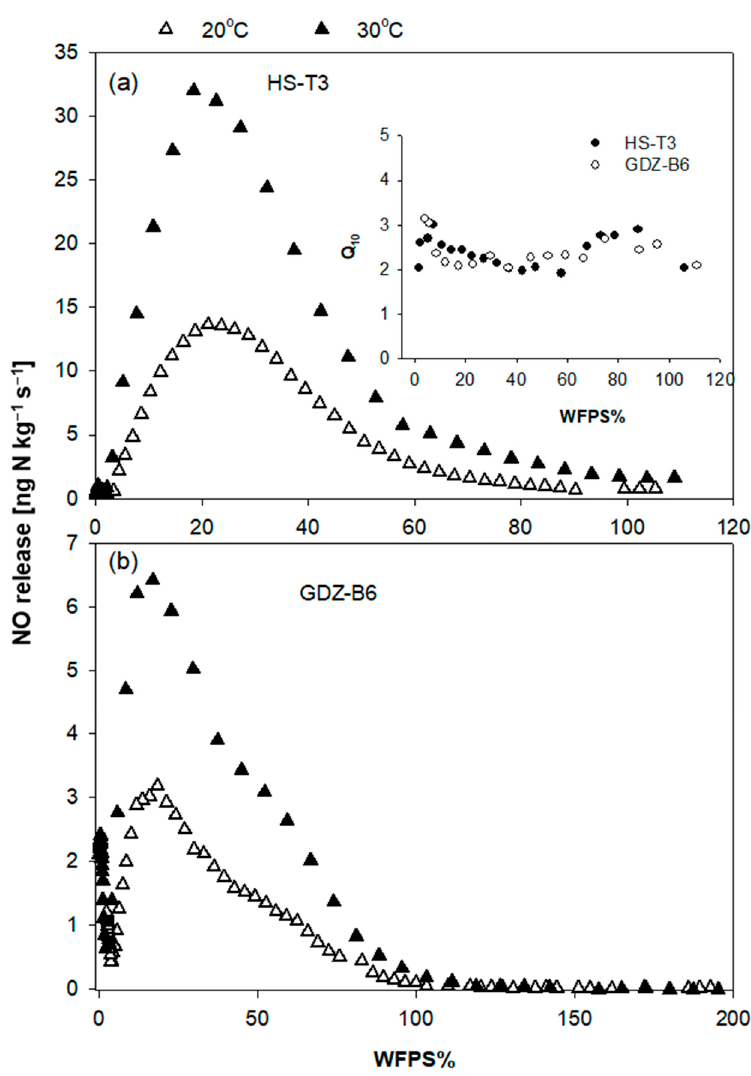
Figure 3. Effect of temperature on net NO-N release of ( a ) HS-T3 and ( b ) GDZ-B6. The insert in ( a ) shows calculated Q10 values for both soils over the entire WFPS range.